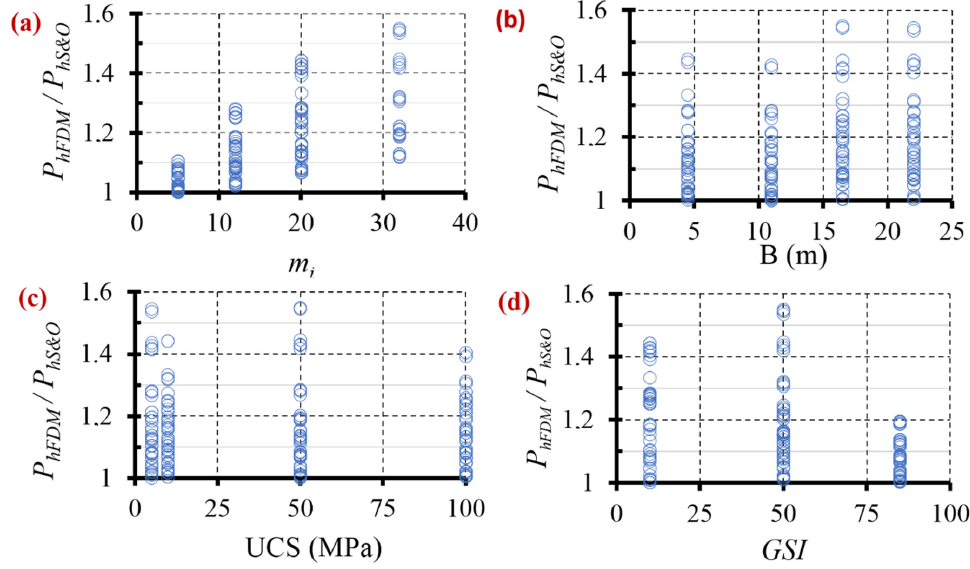
Figure 4. Correlation of P hFDM and P hS&O in function of: ( a ) m i ; ( b ) B ; ( c ) UCS ; ( d ) GSI .